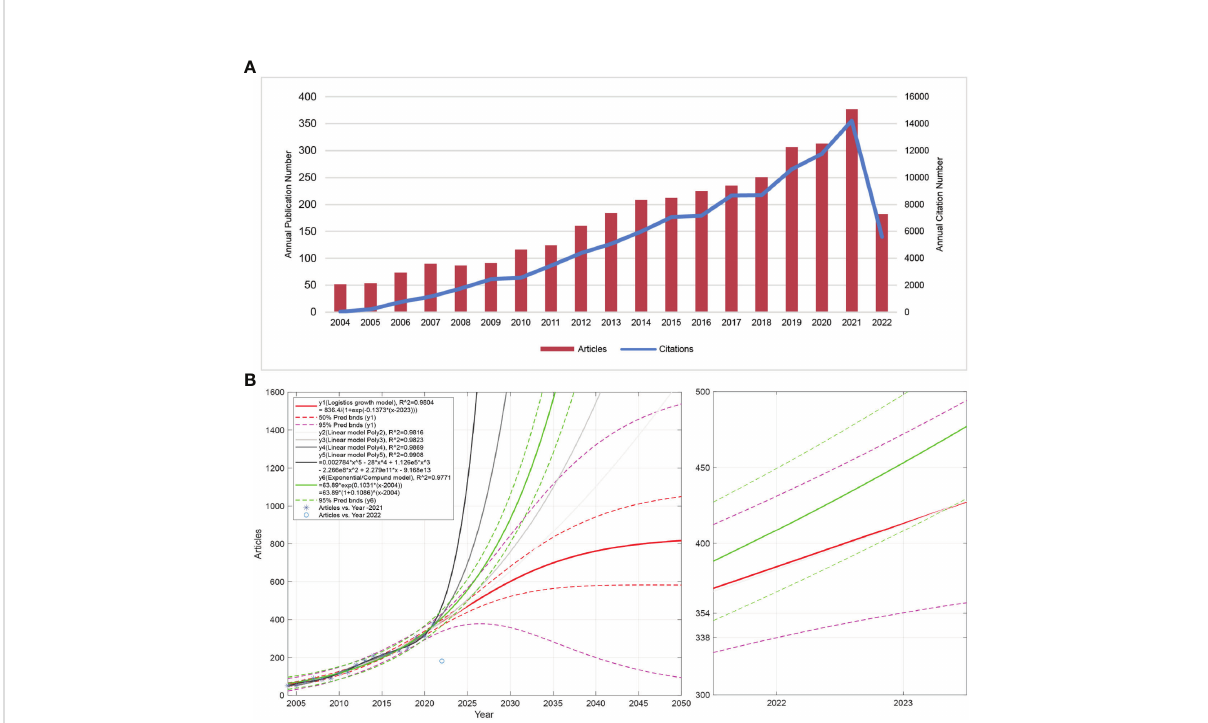
FIGURE 1 Description of NETs-related publication volume and citation frequency and forecast of publication volume. (A) The number of NETs-related publications and citation frequency for each year from 2004 to 2022, with the overall increasing trend of NETs-related publications and citation frequency reaching the maximum in 2021 (2022 data only until July 10). The number of publications fl uctuates between 50-377, with a maximum value in 2021 and an average of more than 240 in the last decade (2012 to 2021). An overall upward trend in citation frequency is observed. (B) The left panel shows the forecast of NETs-related publications from 2022 to 2050, and the right panel shows the forecast of publications in 2022. y1 is the logistic growth model, y2, y3, y4, y5 is the linear model, and y6 is the general model. R^2 is the coef fi cient of the model. The larger the R^2 (close to 1), the better the fi tted regression equation is. “ Pred bnds ” represents the predicted upper and lower